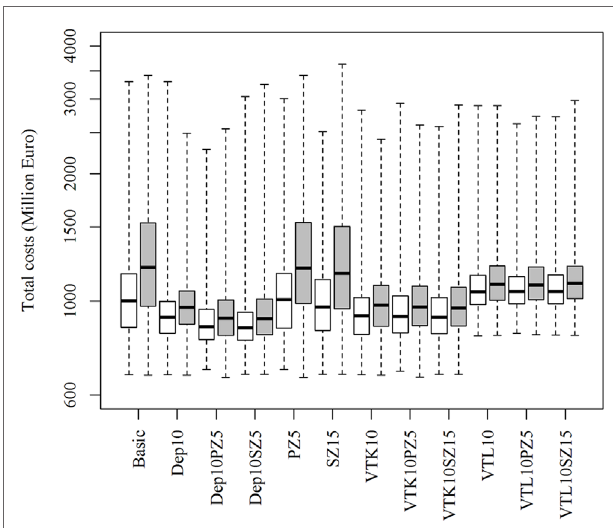
FigUre 3 | Total costs using different strategies to control 1,000 simulated FMD epidemics in Denmark, all initiated in cattle herds, when the probability of low-risk contacts are decreased (white boxes) or increased (gray boxes) by 25% . The basic scenario represents the EU and Danish control regulations (Basic), combined with the enlargement of the protection zone to 5 km (PZ5) and the surveillance zone to 15 km (SZ15), pre-emptive depopulation (Dep) over a 1-km radius around detected herds, and suppressive (VTK) or protective (VTL) emergency vaccination over a 2-km radius around detected herds. Pre-emptive depopulation and vaccination were initiated following the detection of 10 infected herds (10H). Scenarios combining pre-emptive depopulation over 1 km, suppressive or protective emergency vaccination over 2 km and enlarged protection or surveillances zones are also included.